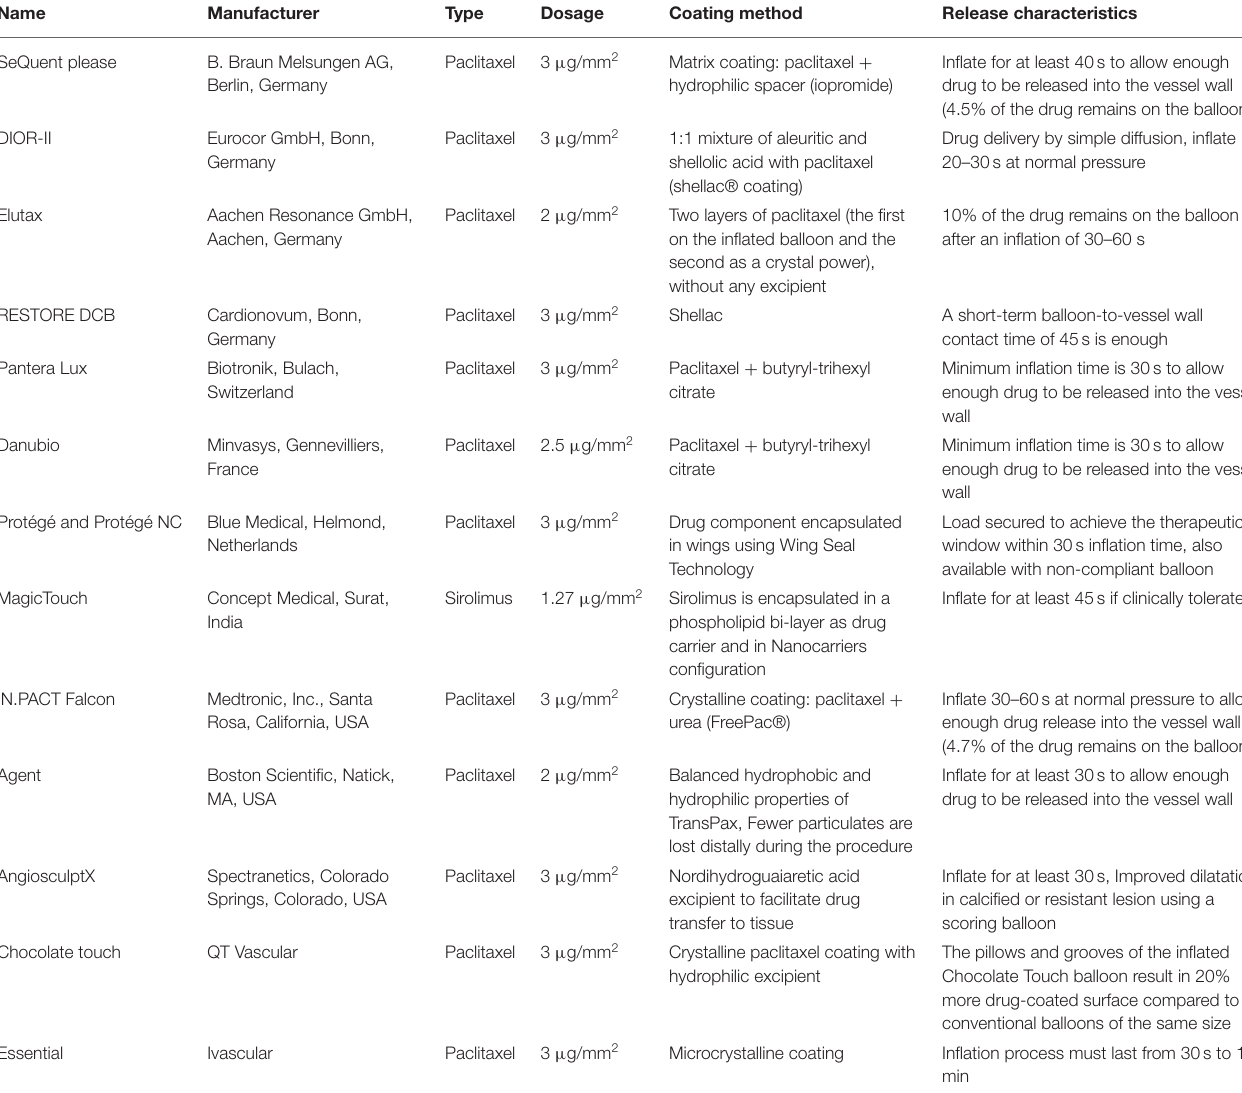
TABLE 1 | Major current drug-coated balloon available in the market